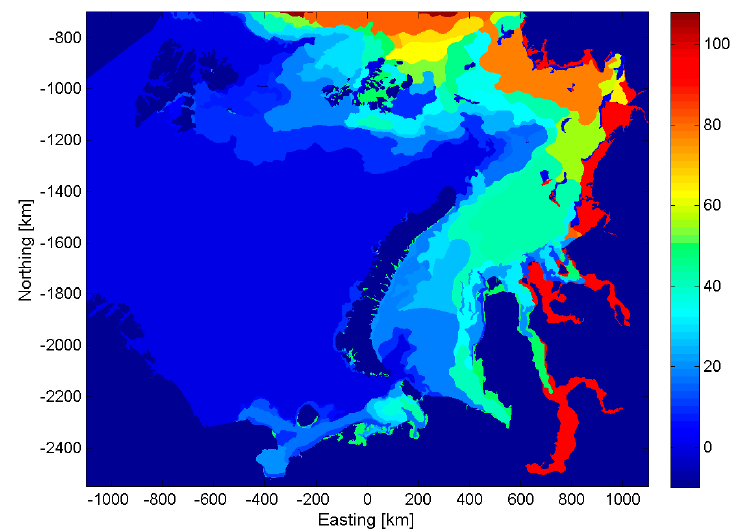
Figure 6. AARI ice chart on 12 January 2016. The original ice chart in the SIGRID-3 shapefile format was gridded to the study area shown in Figure 1 with 1 km pixel size. The chart shows average ice thickness in cm-scale for each polygon, see the text for details of its calculation. Land and missing data are indicate by the dark blue colour ( − 10 cm).